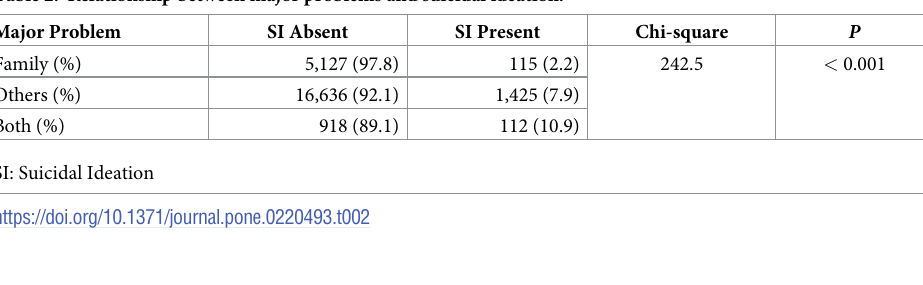
Table 2. Relationship between major problems and suicidal ideation.